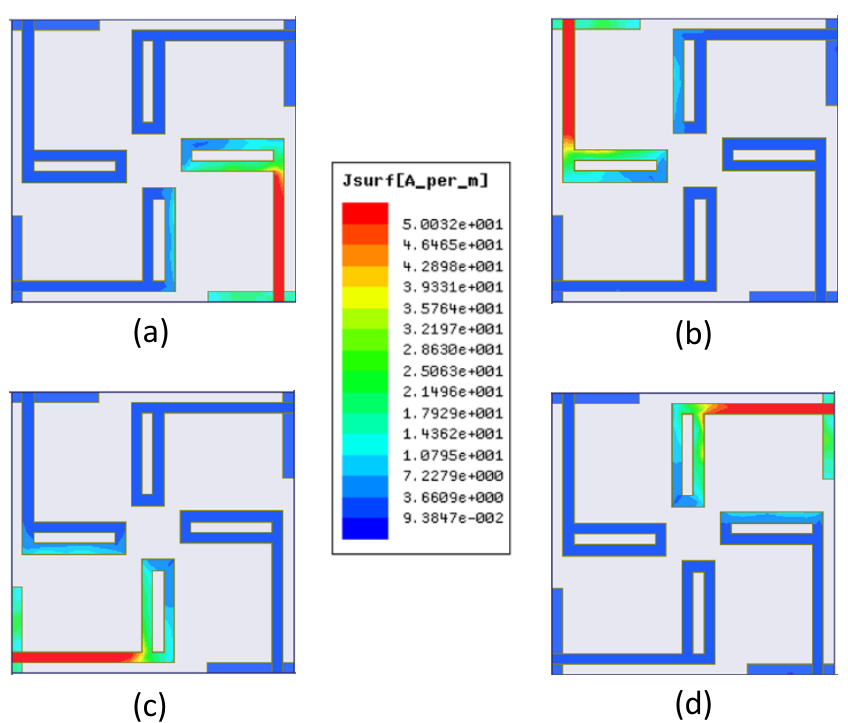
Figure 8. Surface current distribution at 2.4 GHz, ( a ) port 1 excited, ( b ) port 2 excited, ( c ) port 3 excited, ( d ) port 4 excited.